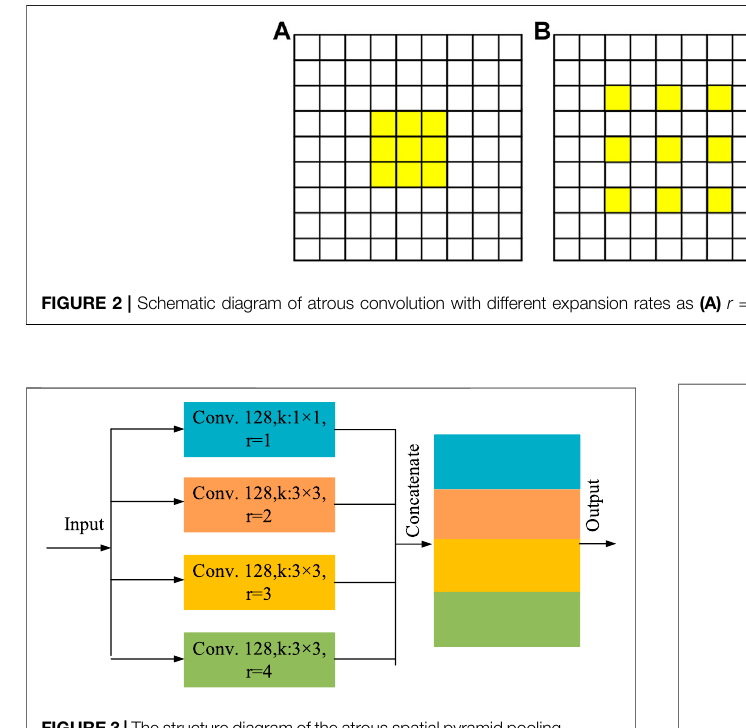
FIGURE 3| The structure diagram of the atrous spatial pyramid pooling.